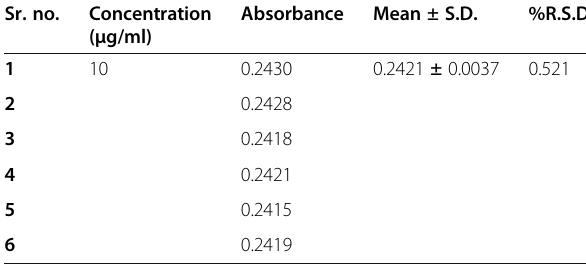
Table 2 Data showing repeatability of absorbances Sr. no.